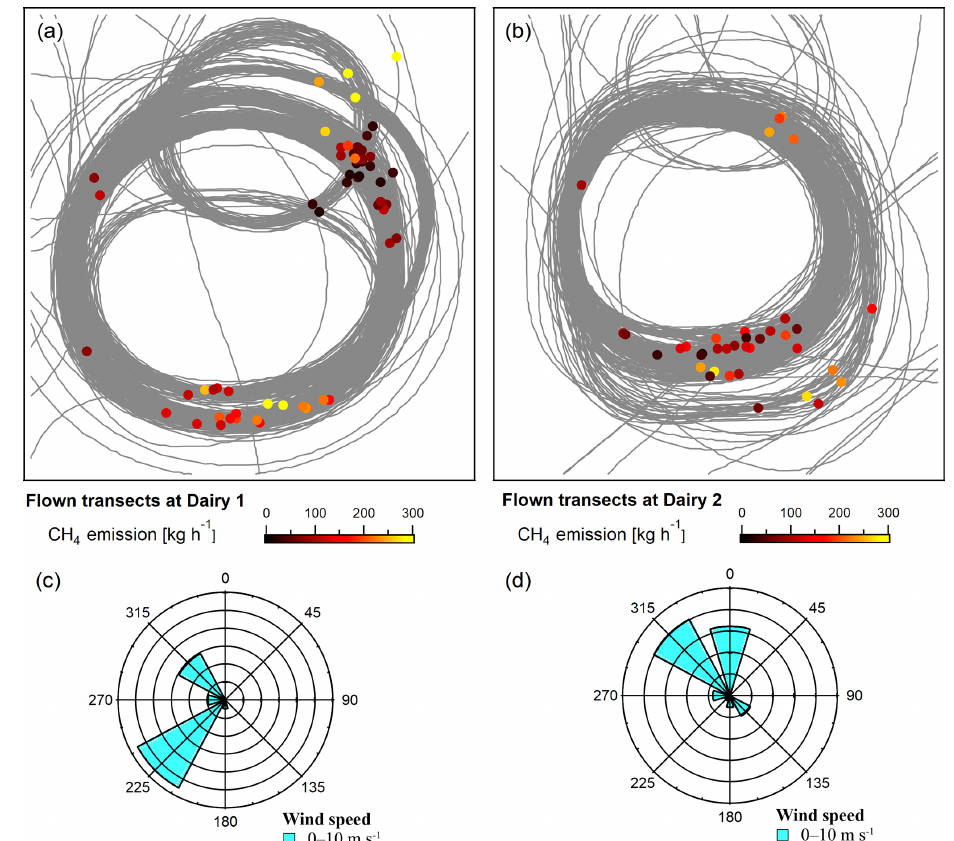
Figure 7. Methane (CH 4 ) emission rates displayed on every flight track as dots, positioned at the midpoint of each enhancement event ( a and b ). Corresponding wind roses average the originating direction and magnitude of the wind from the midpoint of each plume event ( c and d